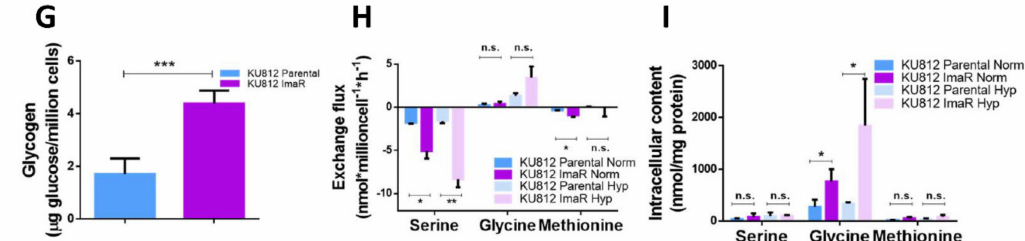
Figure 3. E ff ects of imatinib resistance on glycolysis, glycogen metabolism, pentose phosphate pathway and one-carbon metabolism. ( A ) Exchange fluxes of KU812 Parental (P) and imatinib-resistant (ImaR) cells. Glucose and lactate production rates were obtained under normoxia (Norm) and hypoxia (Hyp). Data (mean ± SD for n = 3 of n = 2 independent experiments) were normalized to cell number and incubation time. ( B ) Ratio lactate produced by glucose consumed using glucose and lactate flux rates under normoxia and hypoxia. Data are mean ± SD for n = 3 of n = 2 independent experiments. ( C ) Extracellular acidification rate (ECAR) measured under normoxia using a XF96 Extracellular Flux Analyzer during sequential injection of glucose, oligomycin and 2-deoxyglucose (2-DG) in KU812 Parental (P) and imatinib-resistant (ImaR) cells previously incubated under normoxic (Norm) and hypoxic (Hyp) conditions. Cells were first incubated in the absence of glucose. Data are mean ± SD for n = 8 replicates of three independent experiments. ( D ) Di ff erences on the protein profiling of proteins associated with the glucose uptake, glucose metabolism and its rewiring to pathways such as glycerol-3-P shuttle, glycogen metabolism, pentose phosphate pathway (PPP), serine synthesis and 1-C metabolism in KU812 cells upon imatinib resistance. The protein expression profiling was obtained under normoxia using SILAC-based proteomic experiments. ( E ) Western blotting analysis of total protein fractions associated with glycolysis and PPP metabolism of KU812 Parental and ImaR cells under normoxia or hypoxia (1% O 2 ). Data are mean ± SD for n = 3 of n = 2 independent experiments.